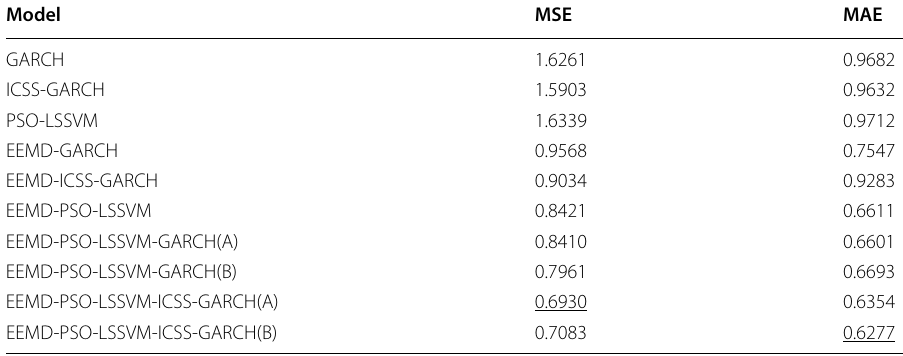
The numbers in the table refer to the values of the two loss functions. The underlined numbers indicate that the corresponding models have the lowest forecasting